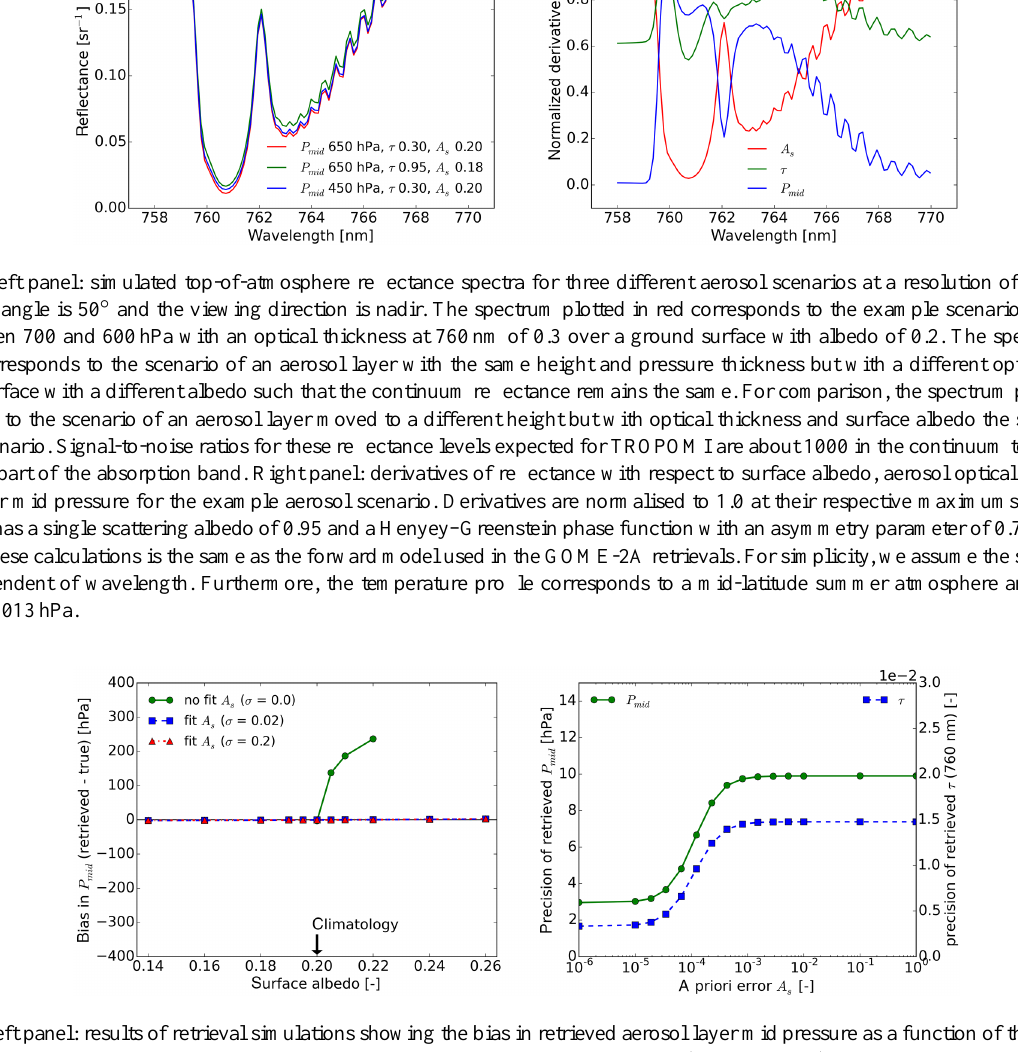
Figure 2. Left panel: results of retrieval simulations showing the bias in retrieved aerosol layer mid pressure as a function of the true surface albedo for three different a priori errors. The a priori value for the surface albedo is 0.20 (“climatology”). Results are shown for the example aerosol scenario (aerosol layer between 700 and 600hPa with optical thickness at 760nm of 0.3, surface albedo of 0.2). Missing data points indicate non-converging retrievals. Right panel: results of retrieval simulations showing precision of retrieved aerosol layer mid pressure and optical thickness as a function of the a priori error in the surface albedo. Both panels: a TROPOMI noise model is used which assumes shot noise throughout and a signal-to-noise ratio of 500 at 758nm for a reference radiance of 4.5 × 10 12 photonss − 1 cm − 2 sr − 1 nm − 1 . The a priori error for aerosol layer mid pressure is 500hPa and for aerosol optical thickness is 1.0. Other details are the same as in Fig.